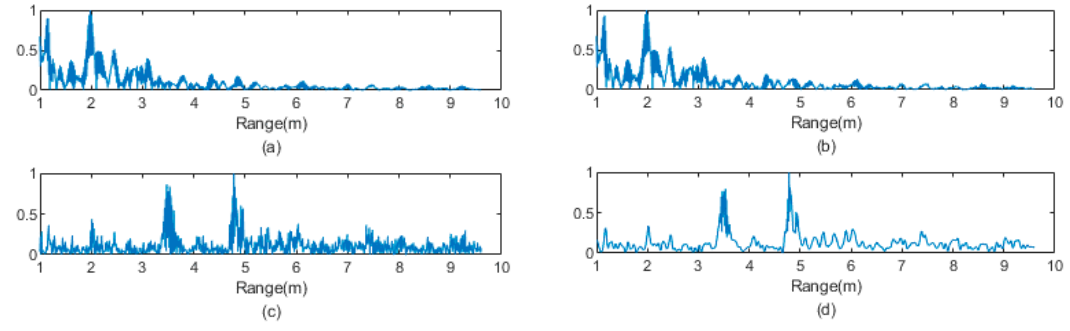
Figure 1. ( a ) Raw echo data that were collected from the impulse–response ultra-wideband (IR-UWB) module and ( b ) reference echo data that were collected when no target was in the monitored area. ( c ) The signal difference that was calculated by subtracting the reference echo data from the raw echo data. ( d ) The result of applying wavelet denoising to the signal difference.